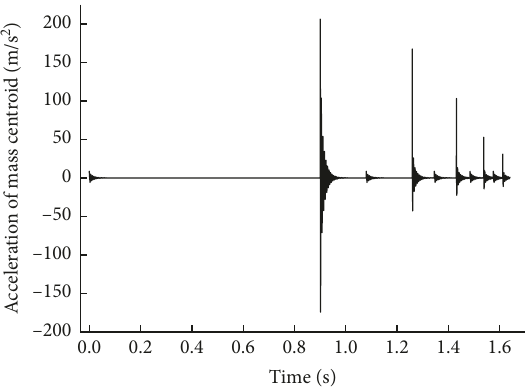
Figure 22: Centroid acceleration of the metal plate.